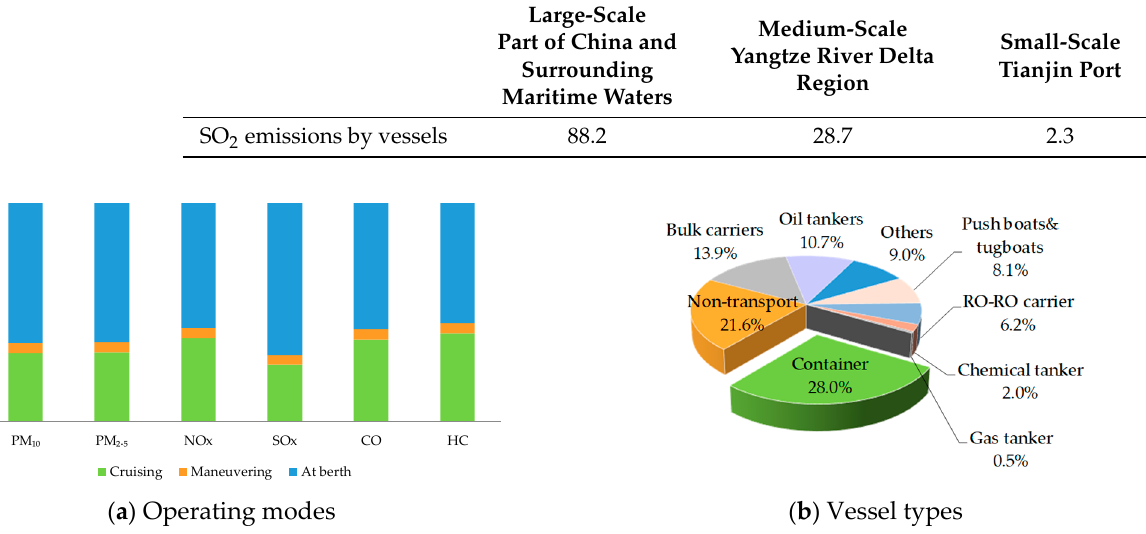
Figure 6. Diagrams of computed results by Method 2 (small-scale region, Tianjin port).